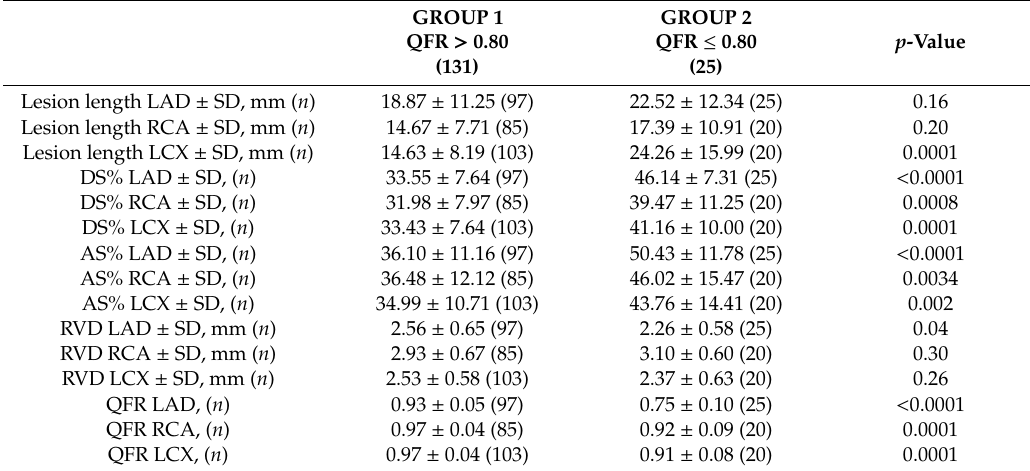
Table 2. Angiographic characteristic of patients presenting with QFR > 0.80 in all the analyzed vessel and those with ≤ 0.80 in at least one